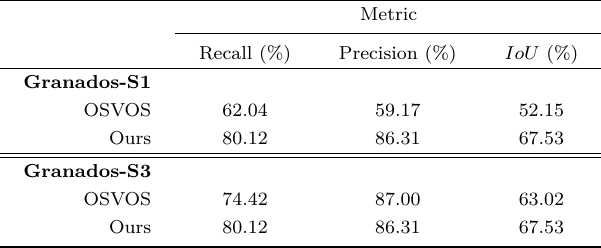
Table 2 Quantitative comparison of our object segmentation method and the OSVOS segmentation method [8], on two sequences manually segmented for inpainting purposes